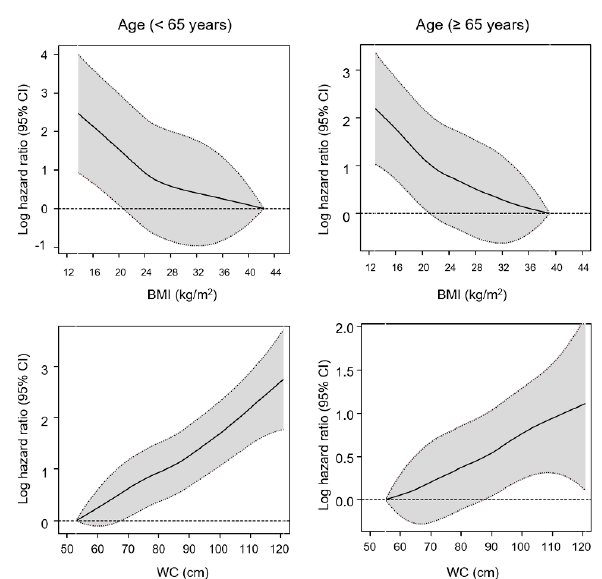
Figure 3. Smoothed hazard ratios curves of the associations of BMI and WC with all ‐ cause mortality in hemodialysis patients, stratified by age and sex. Log hazard ratios are adjusted for age; smoking status; alcohol consumption; regular exercise status; low income; previous history of diabetes, hypertension, dyslipidemia, cardiovascular disease and cancer; and BMI or WC. BMI, body mass index; WC, waist circumference; CI, confidence interval.